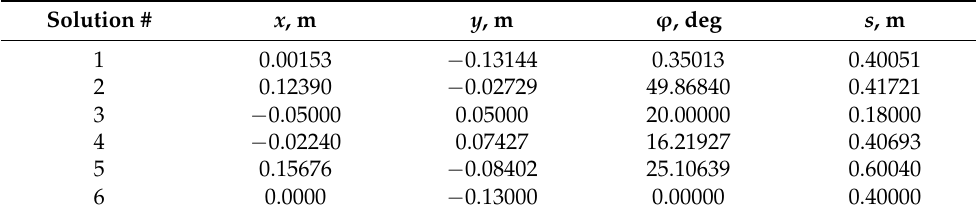
Table 1. Solutions to the forward kinematics.